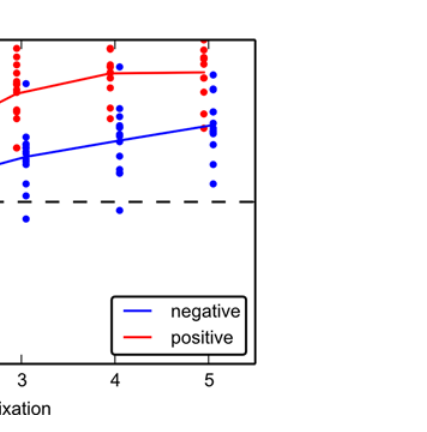
Fig 6. Proportion of fixations on relevant items for the first five fixations in each trial for experiment 1. Only fixations starting after the onset of the array are used. At the start of the trial, there is a small, but significant difference between positive and negative cues. The first fixation following a negative cue is even guided toward irrelevant items. A positive cue guides participants towards relevant items immediately, but negative cues also provide correct guidance from the second fixation